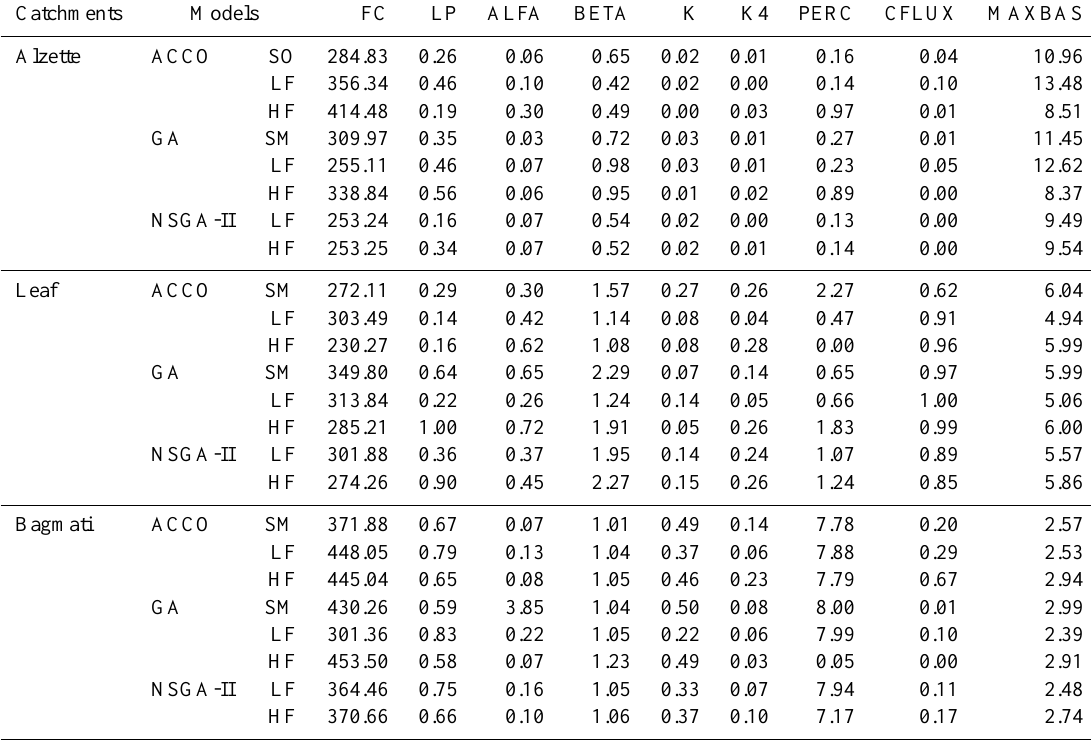
Table 3. Sets of parameters identified by different optimization algorithms. Catchments